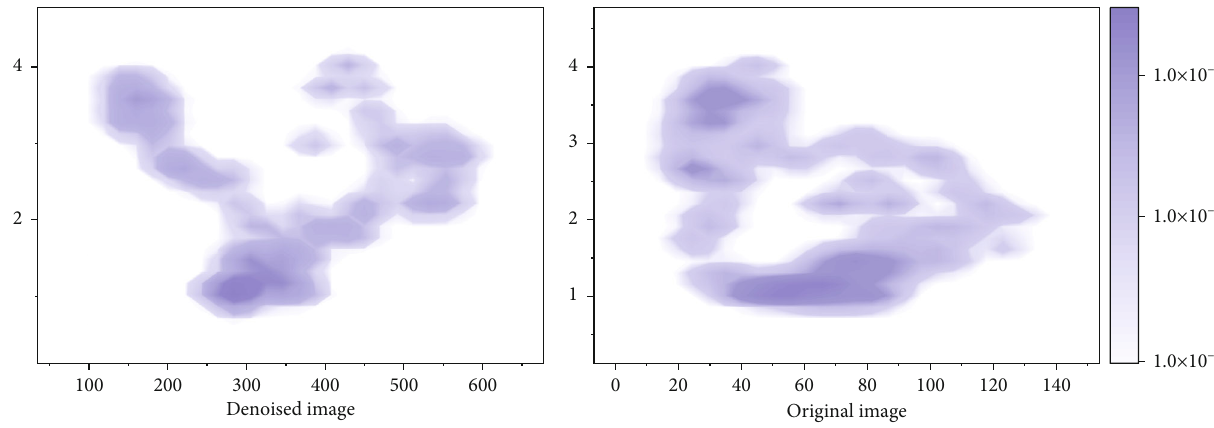
Figure 8: Detailed edge images in di ff erent